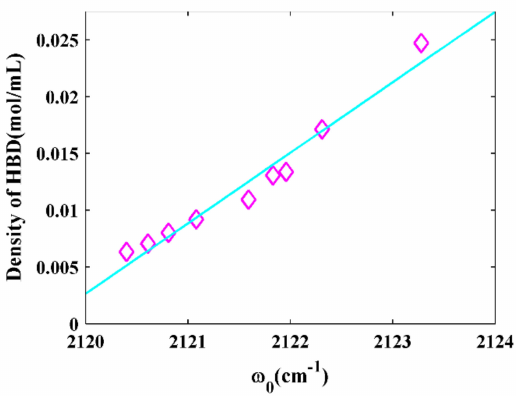
Figure 4. The NC stretching frequencies of 5ICI versus the density of hydrogen-bond donor groups in solvents.